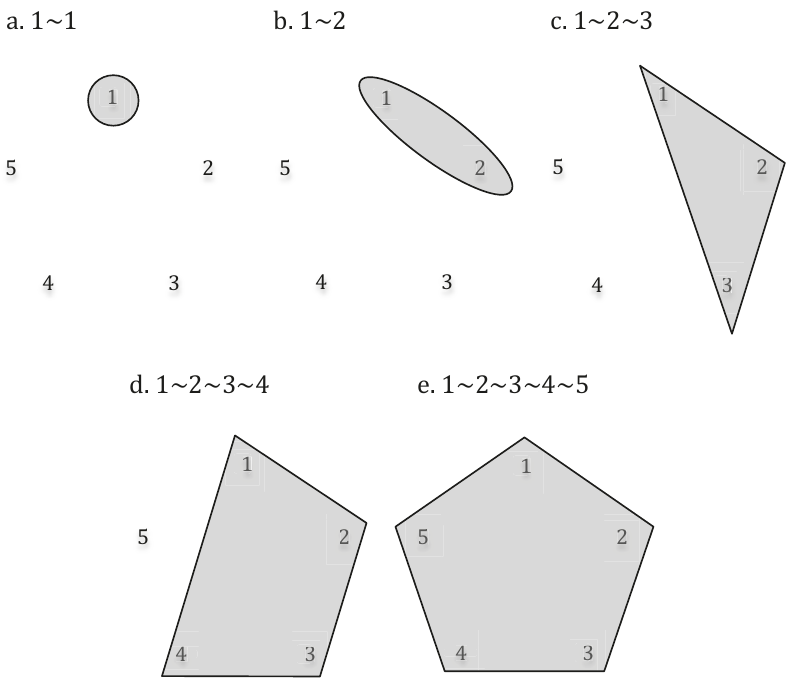
Figure 6. Graphic depictions of the equivalence relations of the five conditions of correspondence for a single tonal identity for all models of harmonic